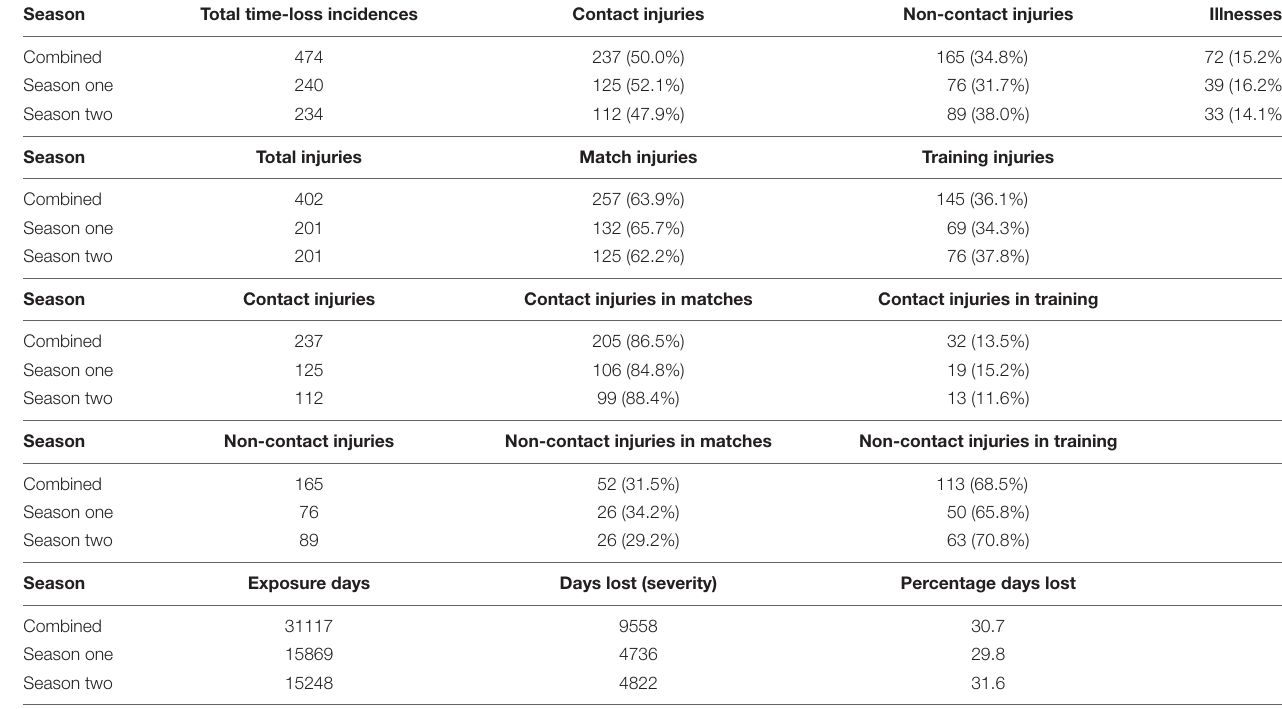
TABLE 1 | Number, nature and severity of time-loss incidences across the two seasons, expressed both as absolute numbers and a percentage of the total time-loss incidences/total injuries/contact injuries/non-contact injuries, as appropriate.